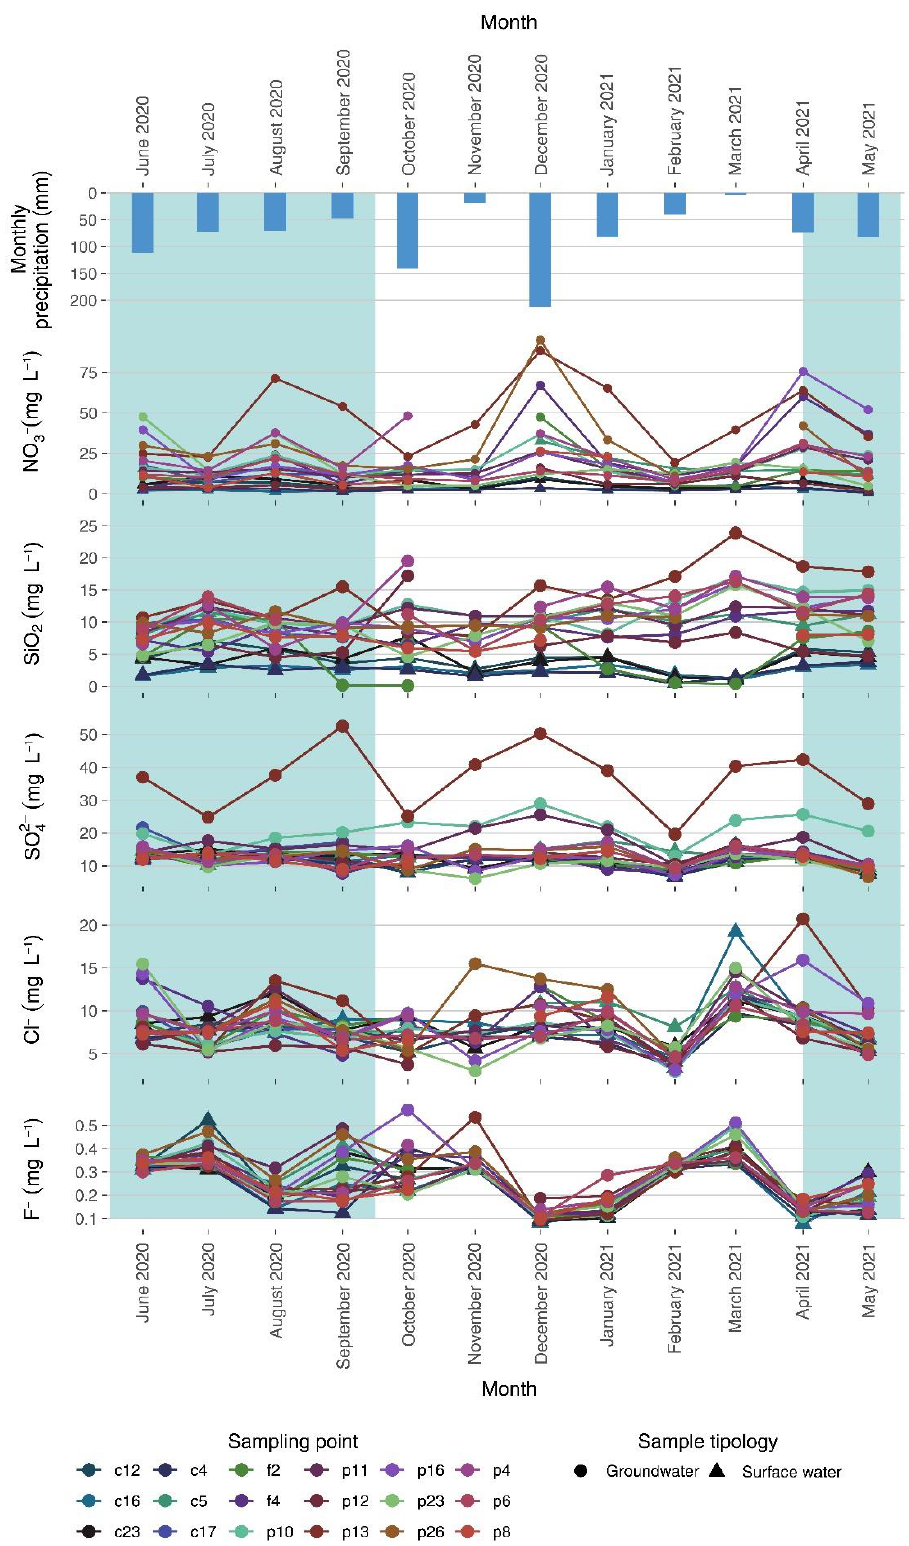
Figure 4. Chemical parameters variation along the hydrological year. NO 3 − showed the most variable concentrations, peaking in three different moments (August 2020, December 2020 and April 2021) with different values (maximum value of 95.034 mg L − 1 NO 3 − ), higher in groundwater and lower in surface waters.